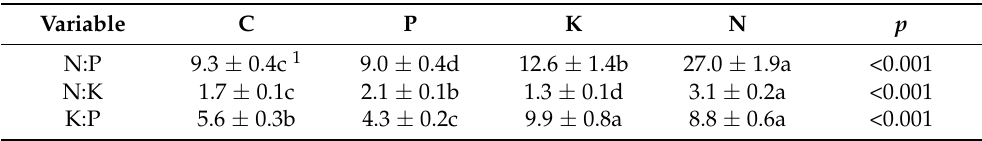
Table 2. The influence of N, P, or K fertilization on stoichiometry of nutrients for Serianthes kanehirae leaves. C = control; P = phosphorus fertilization; K = potassium fertilization; N = nitrogen fertilization. Mean ± SE, n = 6. Variable C P K N p